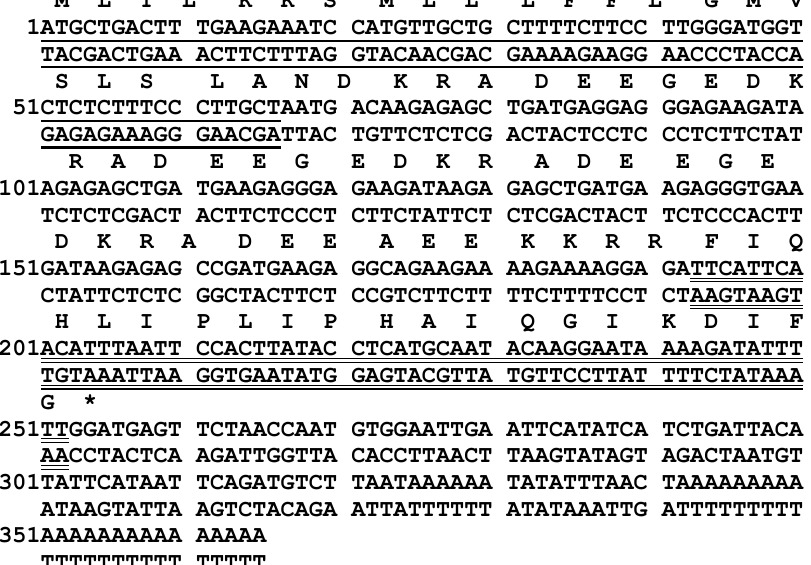
Figure 1. Nucleotide and translated open-reading frame amino acid sequence of the biosynthetic precursor-encoding DNA of kassinatuerin-3. The putative signal peptide sequence is single-underlined, and the mature peptide sequence is double-underlined. The stop codon is indicated by an asterisk (*).